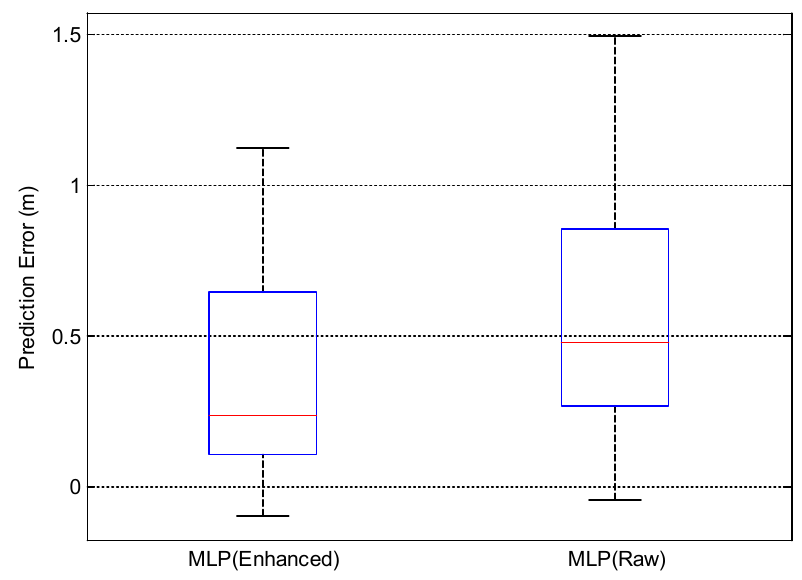
Figure 12. Accuracy of MLP error prediction.